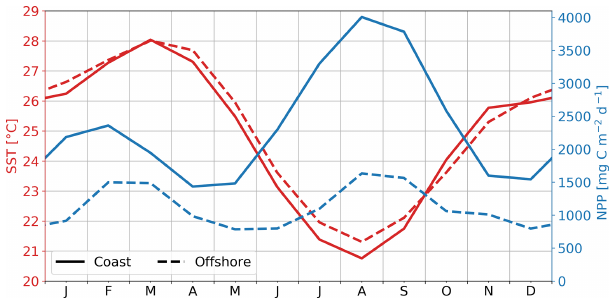
Figure 2. Seasonal cycle of SST (red) and net primary production (blue) averaged over the coastal box (solid lines) and offshore box (dashed lines) shown in Fig.